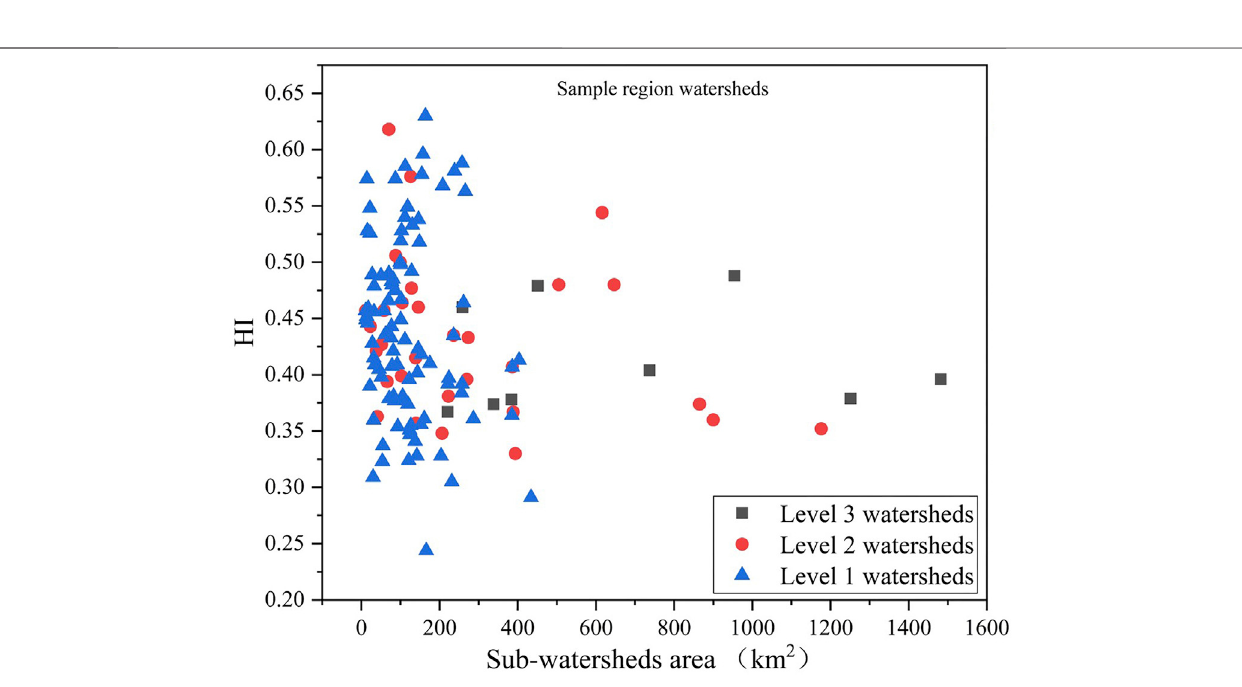
Frontiers in Earth Science |